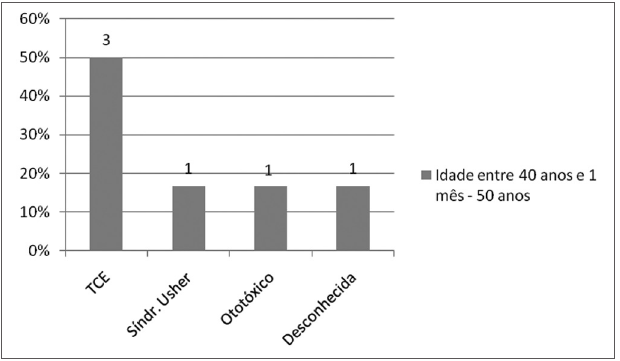
Figura 6. Distribuição etiológica dos pacientes implantados na faixa etária entre 40 anos e 1 mês e 50 anos.